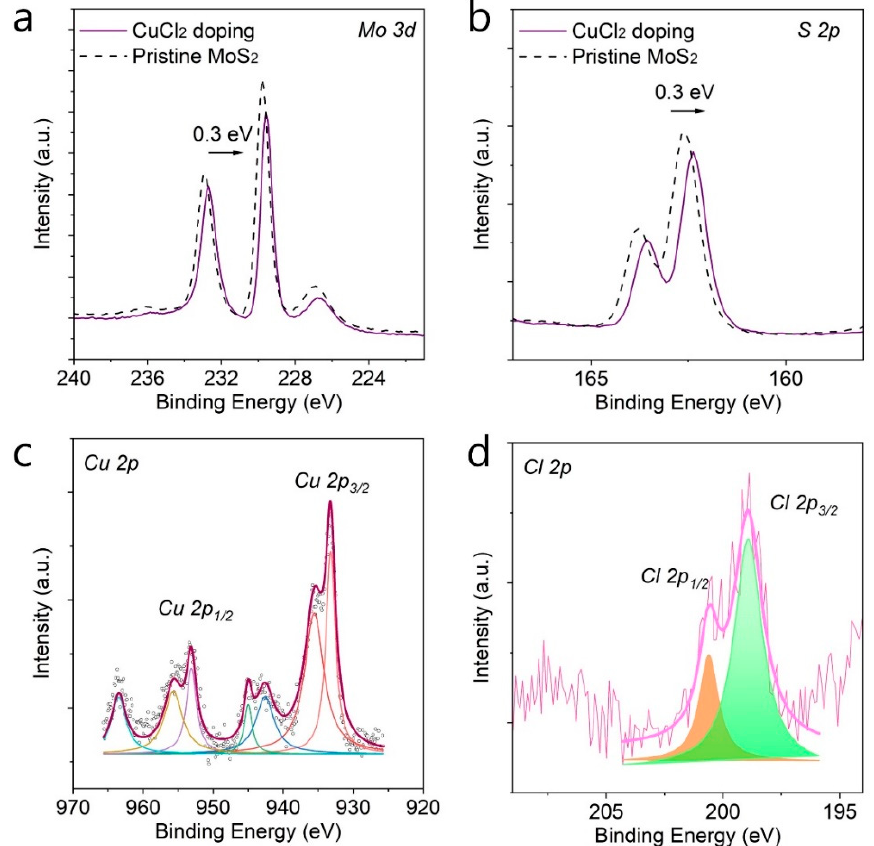
Figure 3. X-ray photoelectron spectroscopy (XPS) measurements before and after CuCl 2 doping. XPS spectrum of ( a ) Mo 3d and ( b ) S 2p before and after CuCl 2 doping. The shift of the binding energies to lower energy indicates lowered Fermi level in MoS 2 . XPS spectrum of ( c ) Cu 2p and ( d ) Cl 2p was found in CuCl 2 doped MoS 2 film, demonstrating the CuCl 2 is doped onto MoS 2 .